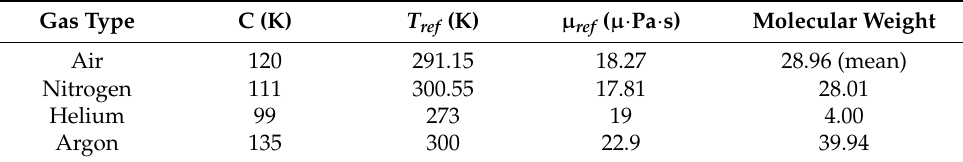
Table 3. Sutherland’s reference values for some gases commonly used in CS